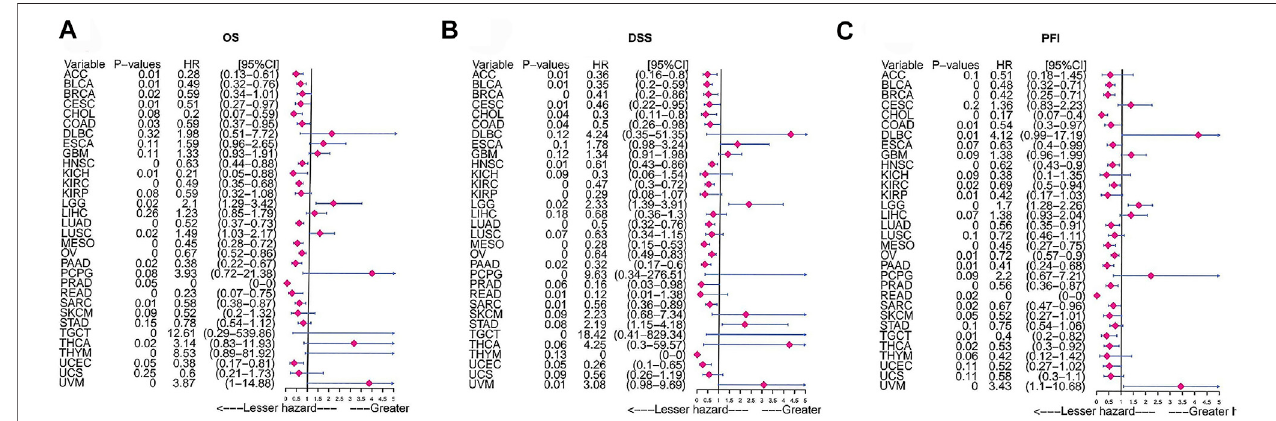
FIGURE 7 | Prognostic analysis of FAM46C via univariate Cox regression. The results of (A) OS analysis, (B) DSS analysis and (C) PFI analysis in pan-cancer.